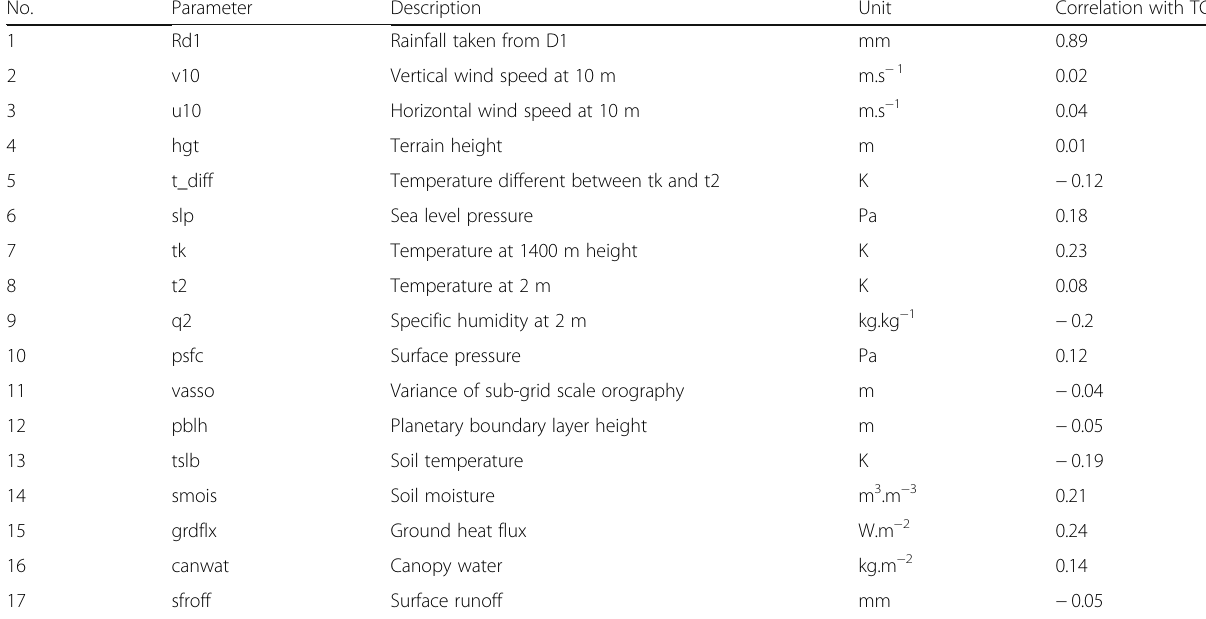
Table 2 Predictor variables considered in the preliminary test